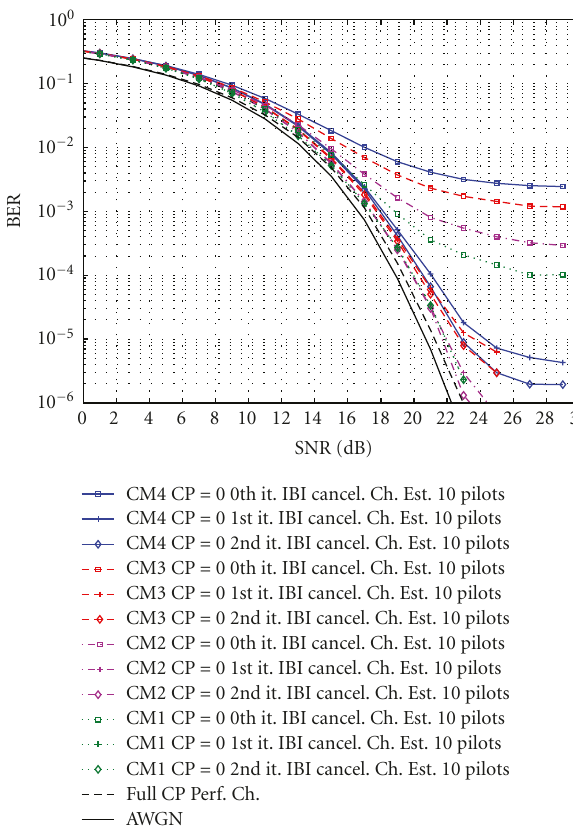
Figure 5: Receiver performance over di ff erent channel models, for CP = 0 and channel estimation with 10 pilot